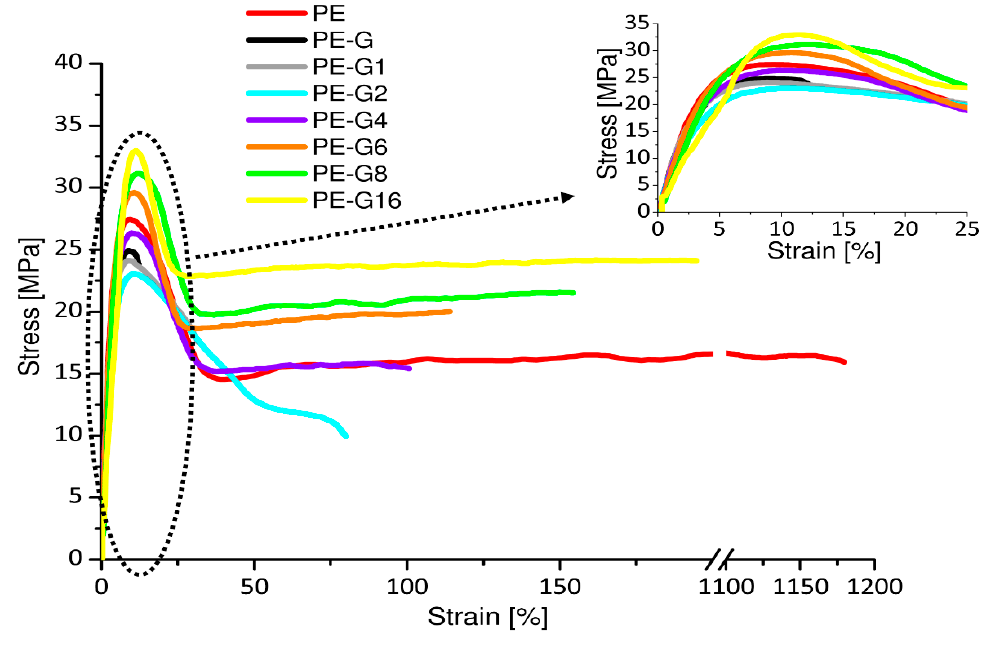
Figure 5. Stress–strain curves of PE and its nanocomposites.